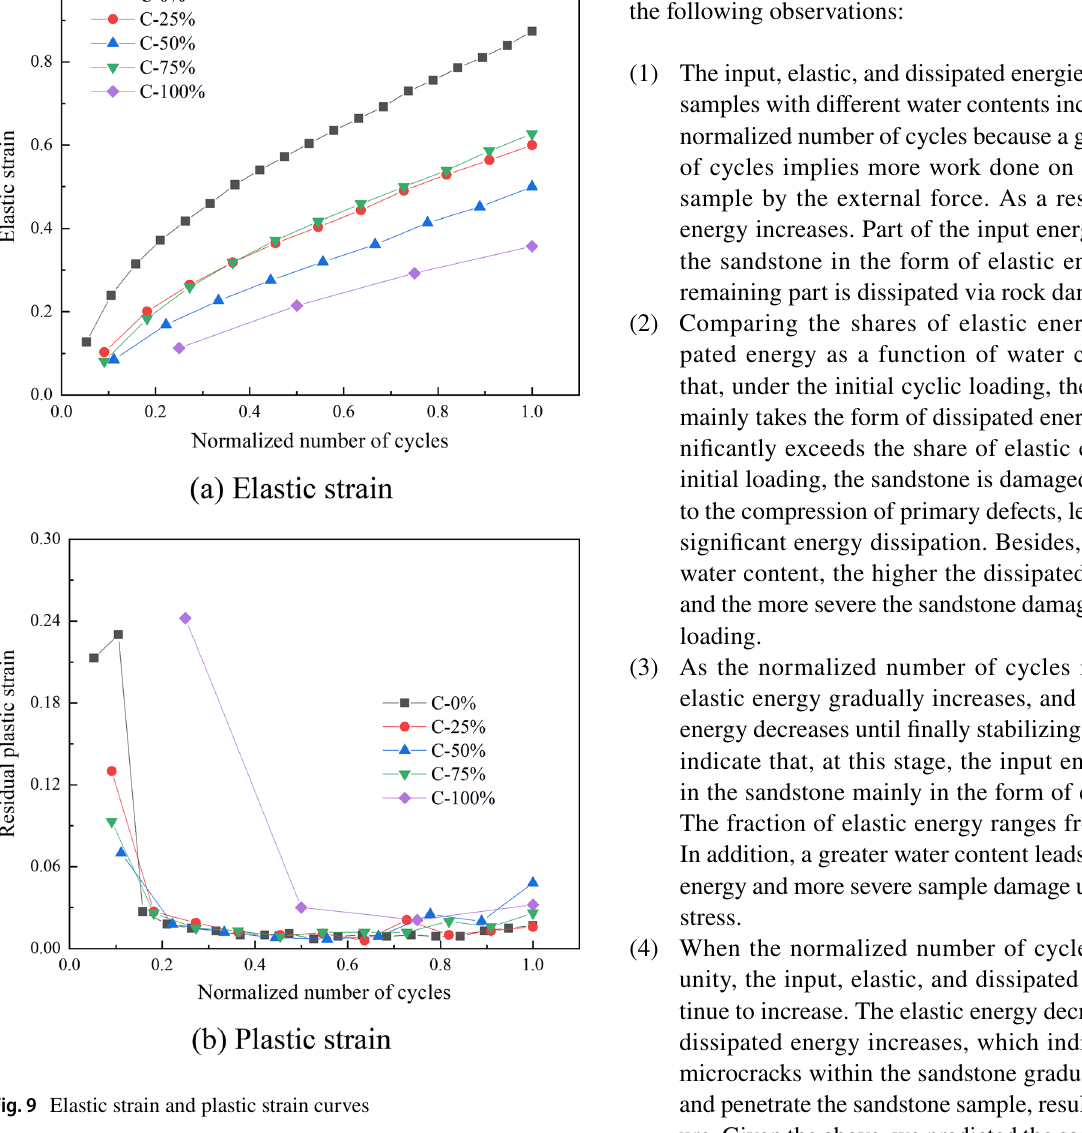
Fig. 9 Elastic strain and plastic strain